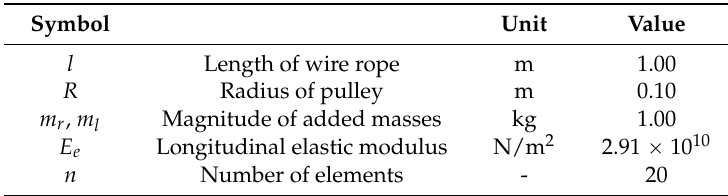
Table 1. Parameter values used in this simulation.